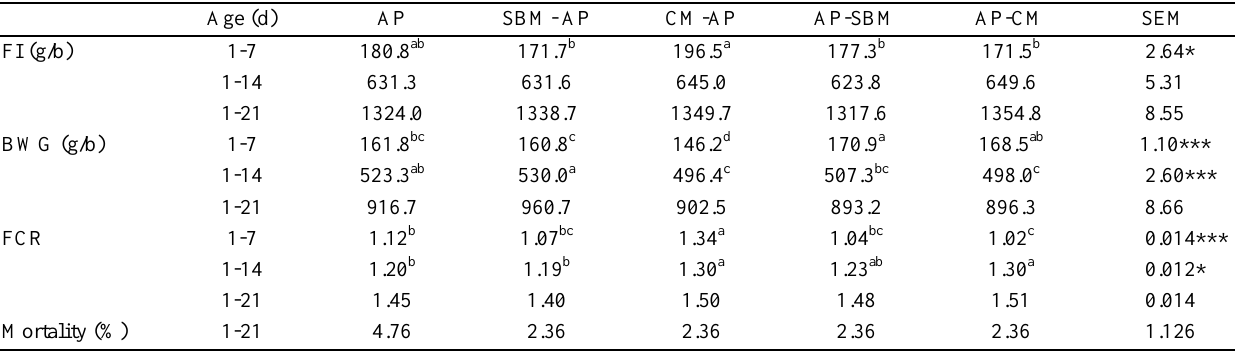
Table 3. Feed intake (FI), body weight gain (BWG), feed conversion ratio (FCR) and mortality of broilers from d1 to 21 days of age